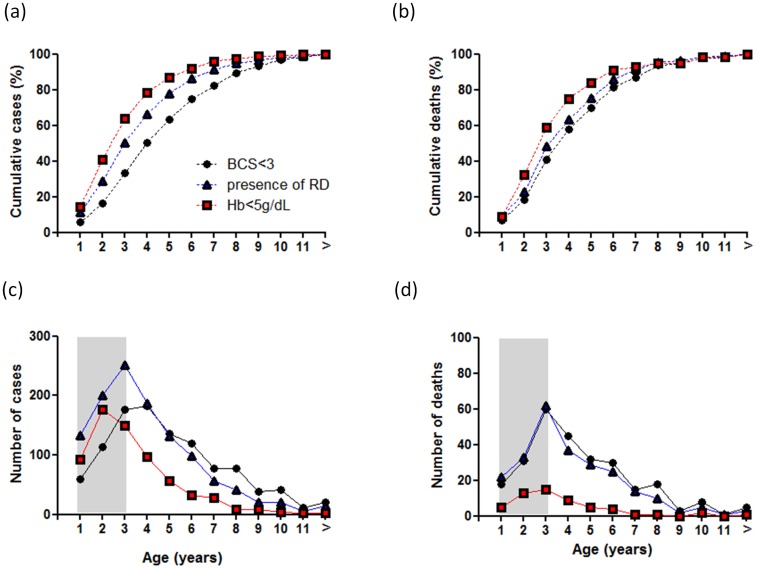
Age distribution of severe malaria syndromes and mortality in Gambian children from 1997 to 2009.Data show the cumulative percentage of children with severe malaria (a), the cumulative percentage of death per age group (b), and absolute number of cases of these SM syndromes (c) and death per age group (d). Age groups indicate year of life: age group 1 includes children up to 12 months of age.